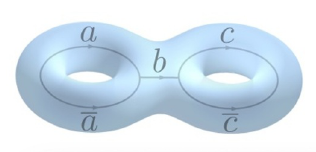
Figure 12 . All possible admissible label sets are f a; b; c g = f 1 ; 1 ; 1 g ; f ; 1 ; 1 g ; f 1 ; 1 ; g ; f ; 1 ; g ; f (cid:27); 1 ; 1 g ; f 1 ; 1 ; (cid:27) g ; f (cid:27); 1 ; g ; f ; 1 ; (cid:27) g ; f (cid:27); 1 ; (cid:27) g ; f (cid:27); ; (cid:27) g